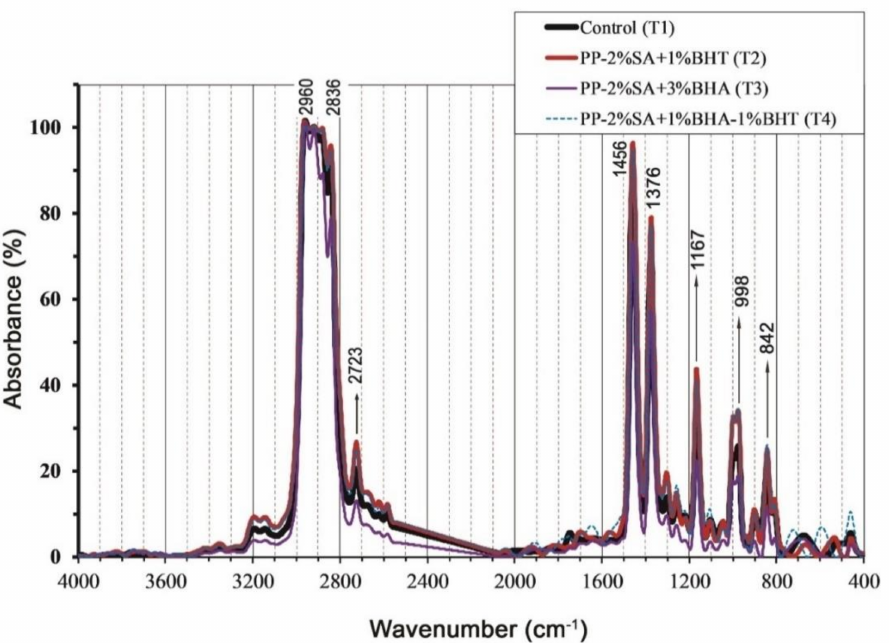
Figure 4. FTIR spectra of pure polypropylene (control, T 1 ), PP-2%SA-1%BHT (T 2 ), PP-2%SA-3%BHA (T 3 ) and PP-2%SA-1%BHT-1%BHA (T 4 ) packaging